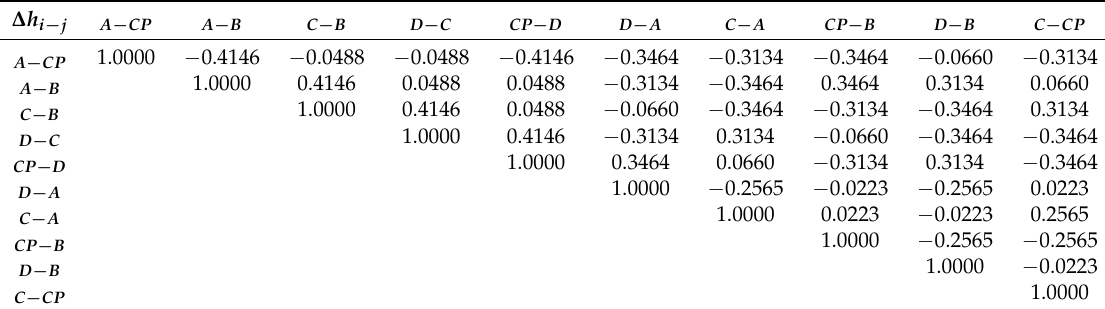
Table 2. Correlation matrix of w -test statistics for levelling network ( a ).